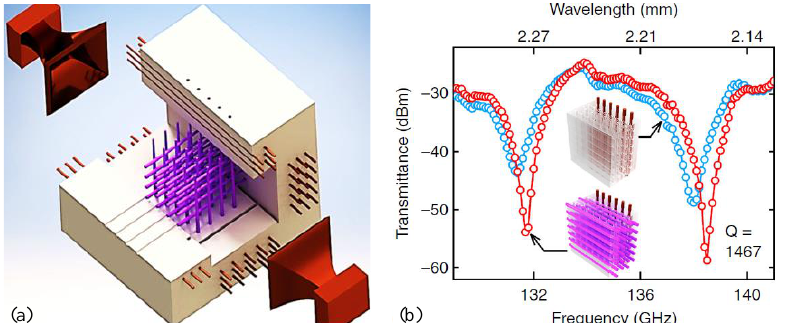
Figure 7. Microplasma column array and its filtering characteristic diagram. ( a ) Schematic diagram of the electrode structure with a lattice constant of 1.5 mm and the discharge diagram of the micro- plasma column array; ( b ) variation of millimeter-wave transmission coefficient with electromag- netic wave frequency in TE mode [56].